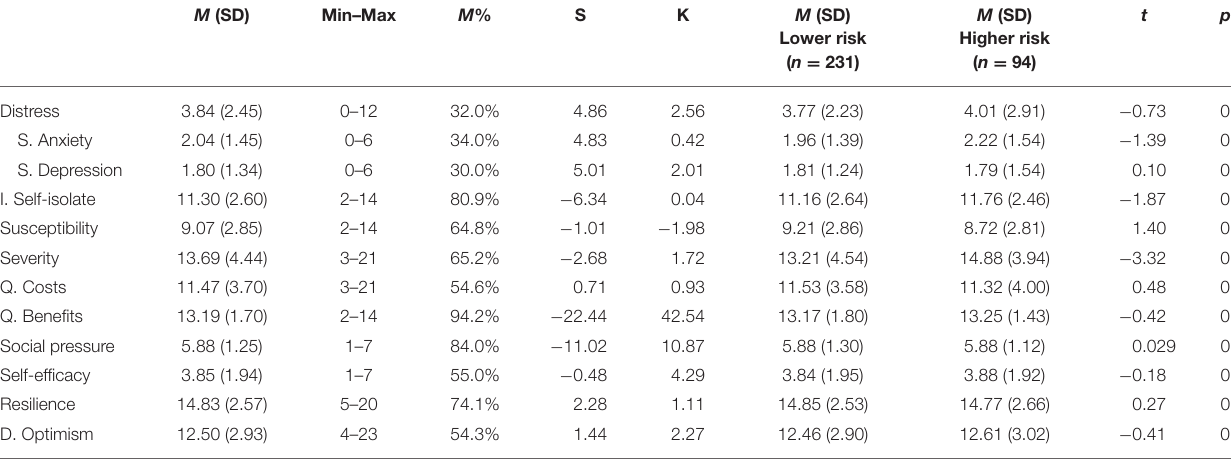
TABLE 3 | Descriptive analyses of the variables in the